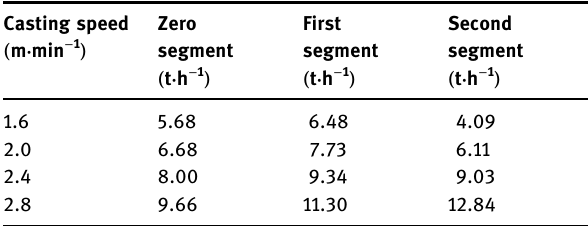
Table 2: Secondary cooling parameters under di ff erent